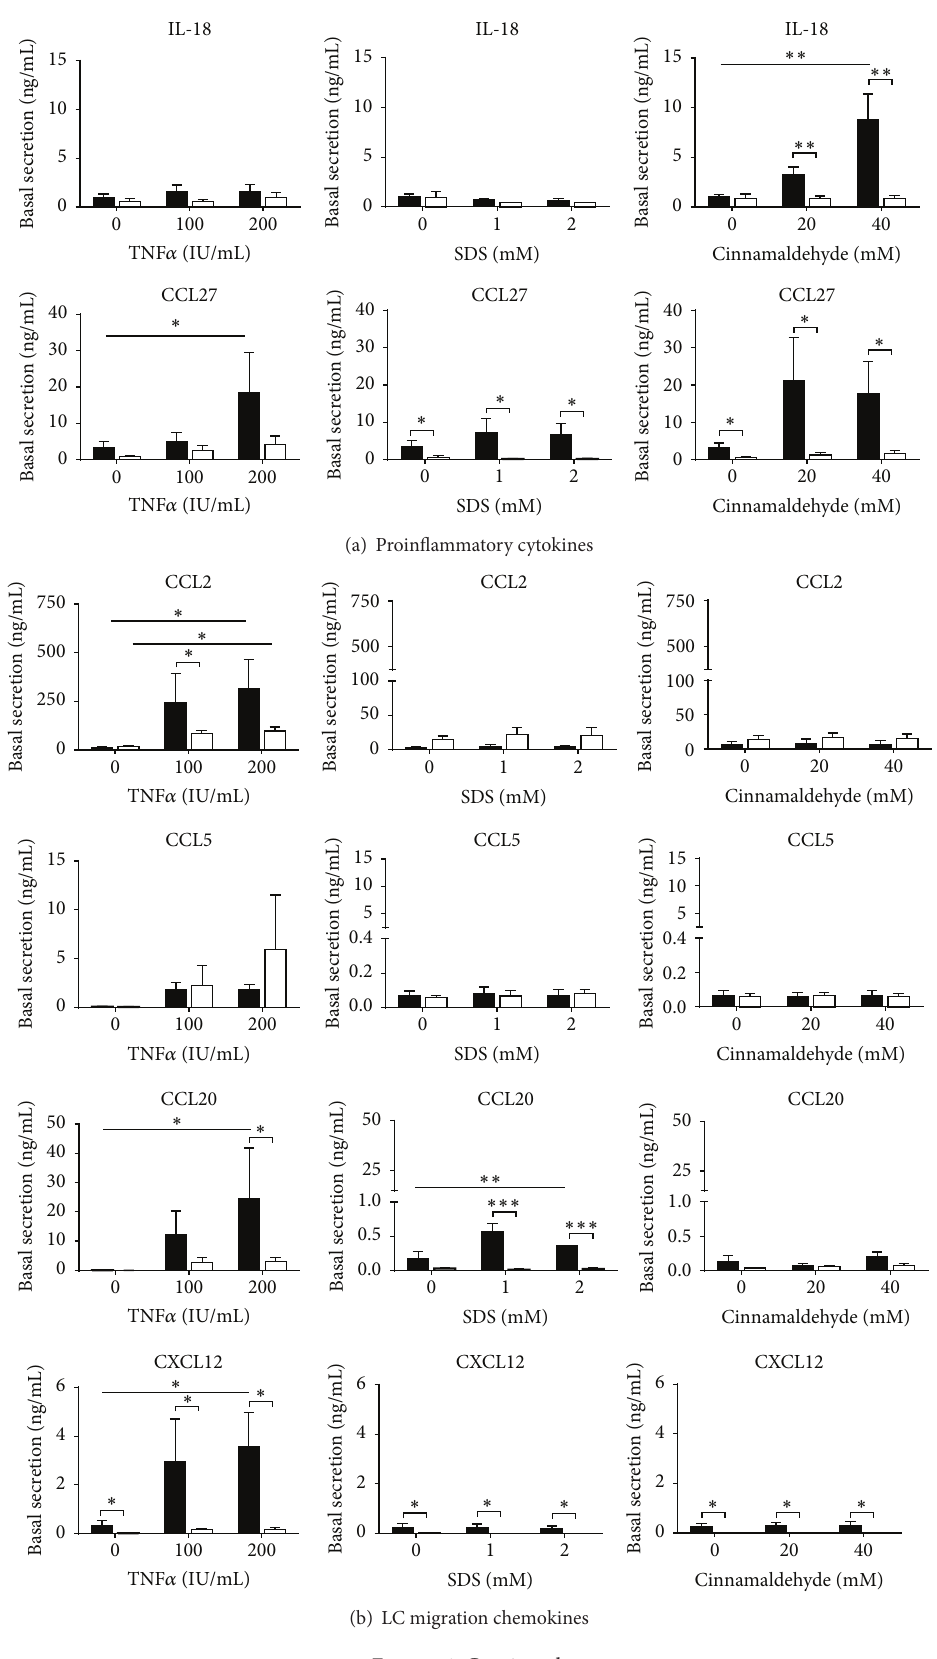
(b) LC migration chemokines Figure 4: